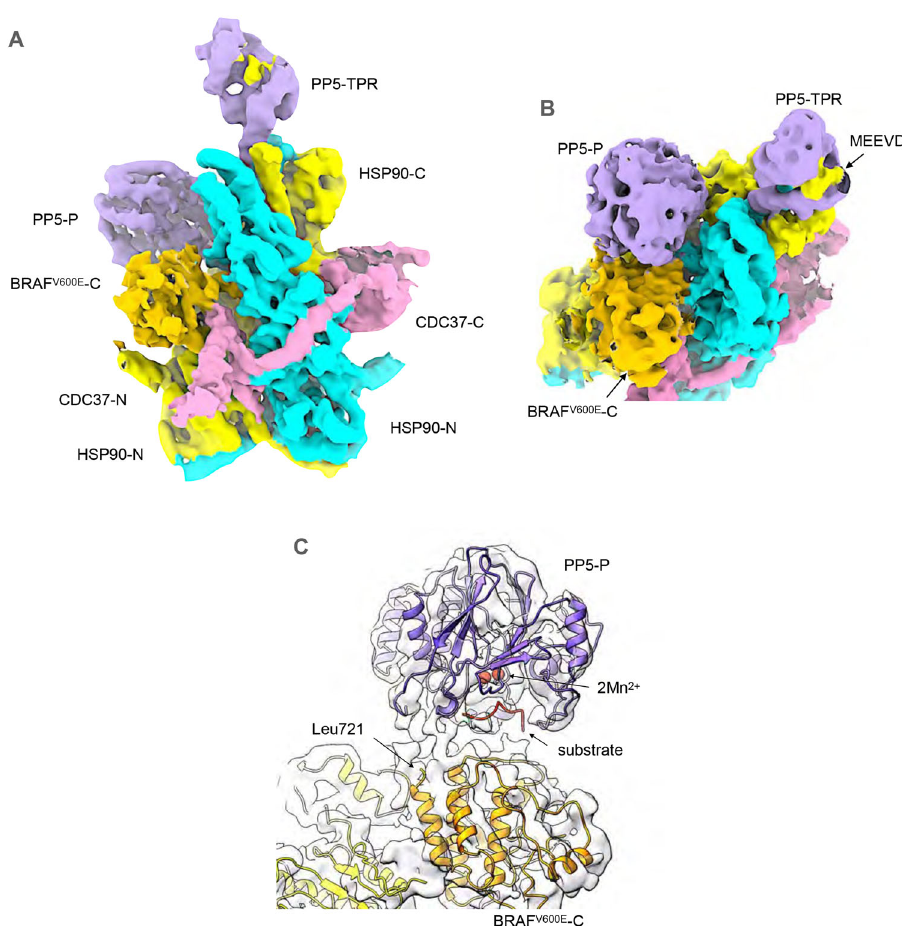
Fig. 3 | Structure of HSP90 – CDC37 – BRAF V600E complex with activated PP5. A Experimental cryoEM map of HSP90 – CDC37 – BRAF V600E – PP5 complex, surface coloured as Fig. 2. The resolution of the region of the map corresponding to PP5 does notallowabinitiotracing ofthe polypeptidechain, whichhastherefore been modelledbyrigid-bodydockingofpreviouslydeterminedcrystalstructuresforthe globular regions into the corresponding volume. The fi t of the molecular model wasthenoptimisedbyreal-spacere fi nement. B Liketheautoinhibitedcomplex,the cryoEMmapsuggeststhepresenceofaboundC-terminalHSP90MEEVDmotifand the tipofthe last helix of the TPRpacksintothe equivalent hydrophobic pocket in